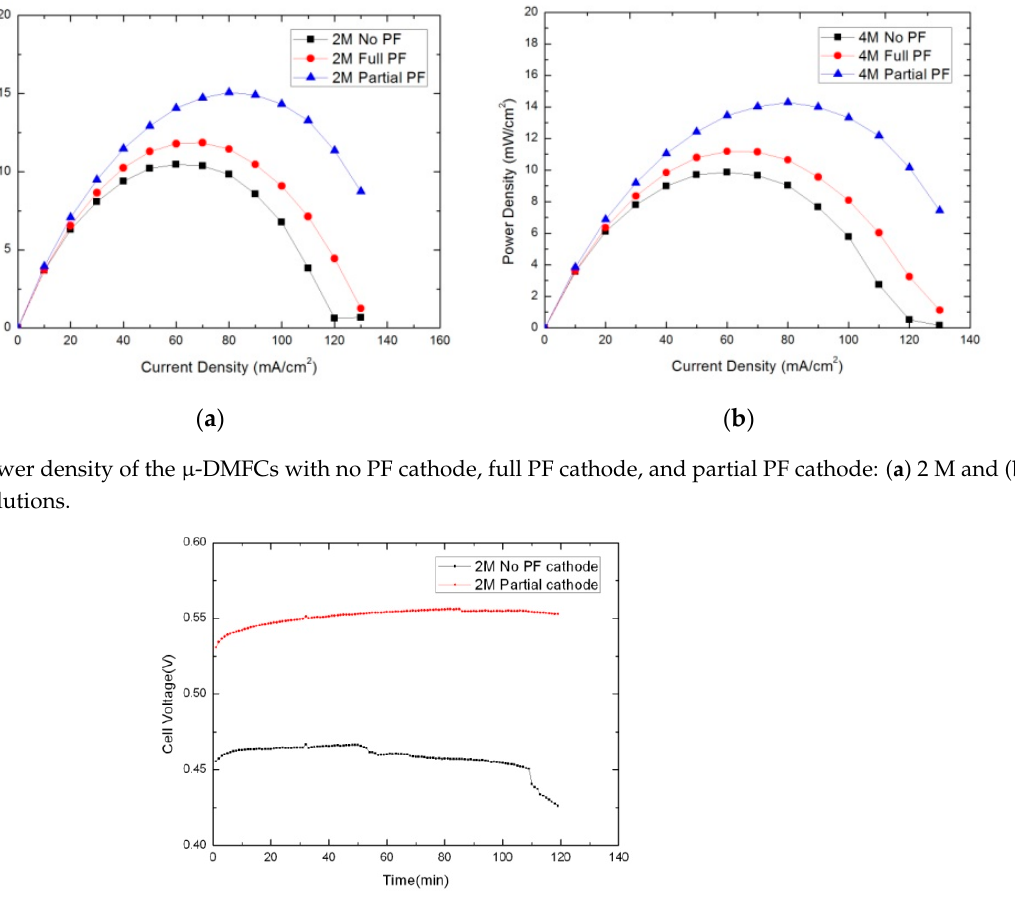
Figure 8. The cathode potential of no PF cathode and partial PF cathode under 80 mA cm − 2 with 2 M methanol solution.